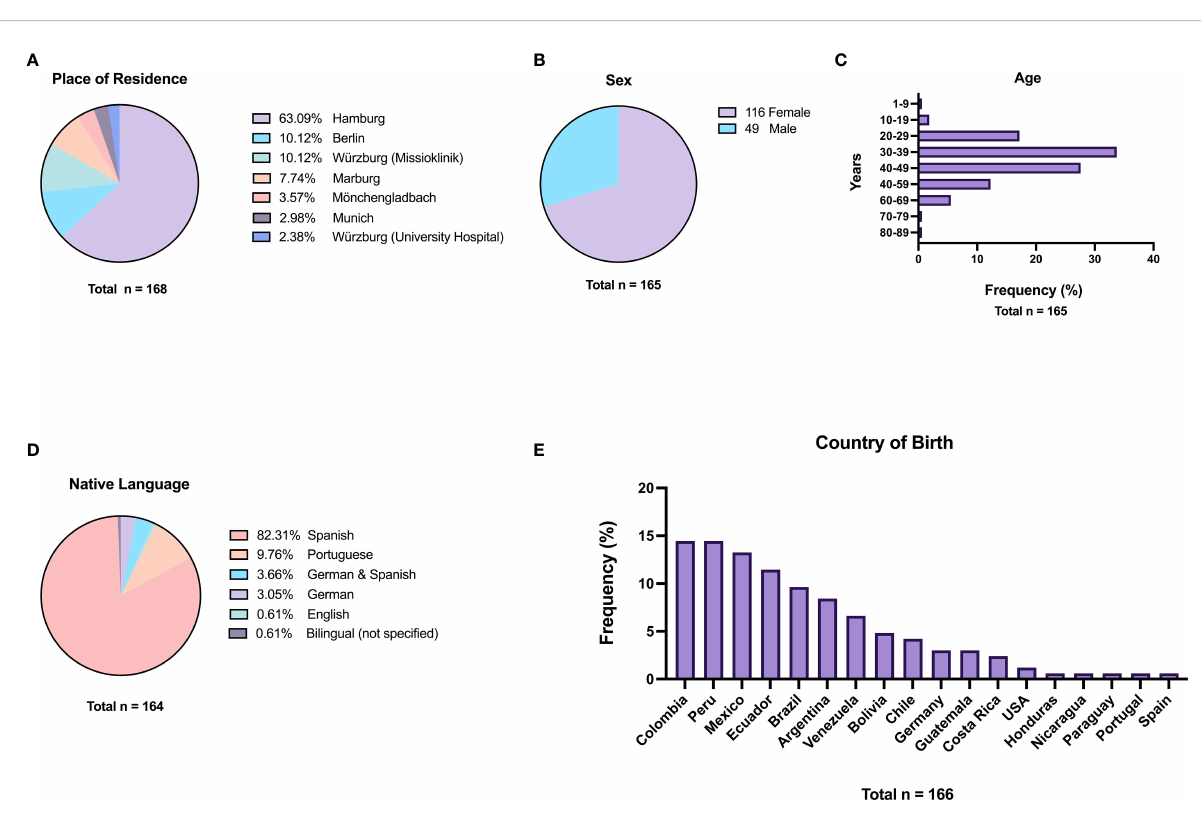
FIGURE 1 Characteristics of the study participants. (A) Place of residence in Germany; (B) Sex; (C) Age at time of study; (D) Native language; (E) Country of